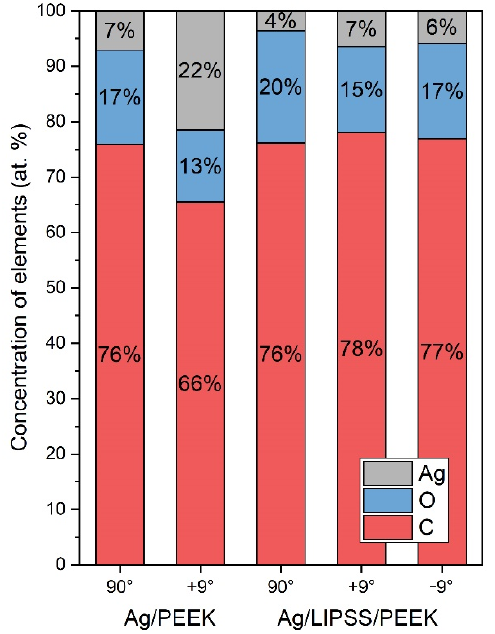
Figure 4. Concentration (at.%) of Ag (3d), O (1s), C (1s) on the surface of PEEK (Ag/PEEK) and PEEK with LIPSS structure (Ag/LIPSS/PEEK) after immobilization with AgNPs, measured by XPS. The analysis was carried out in a perpendicular (90°) and a tilted angle geometry (+9°, − 9°).